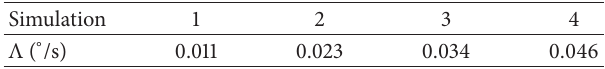
Table 4: Varying Λ while Ω = 360 ∘